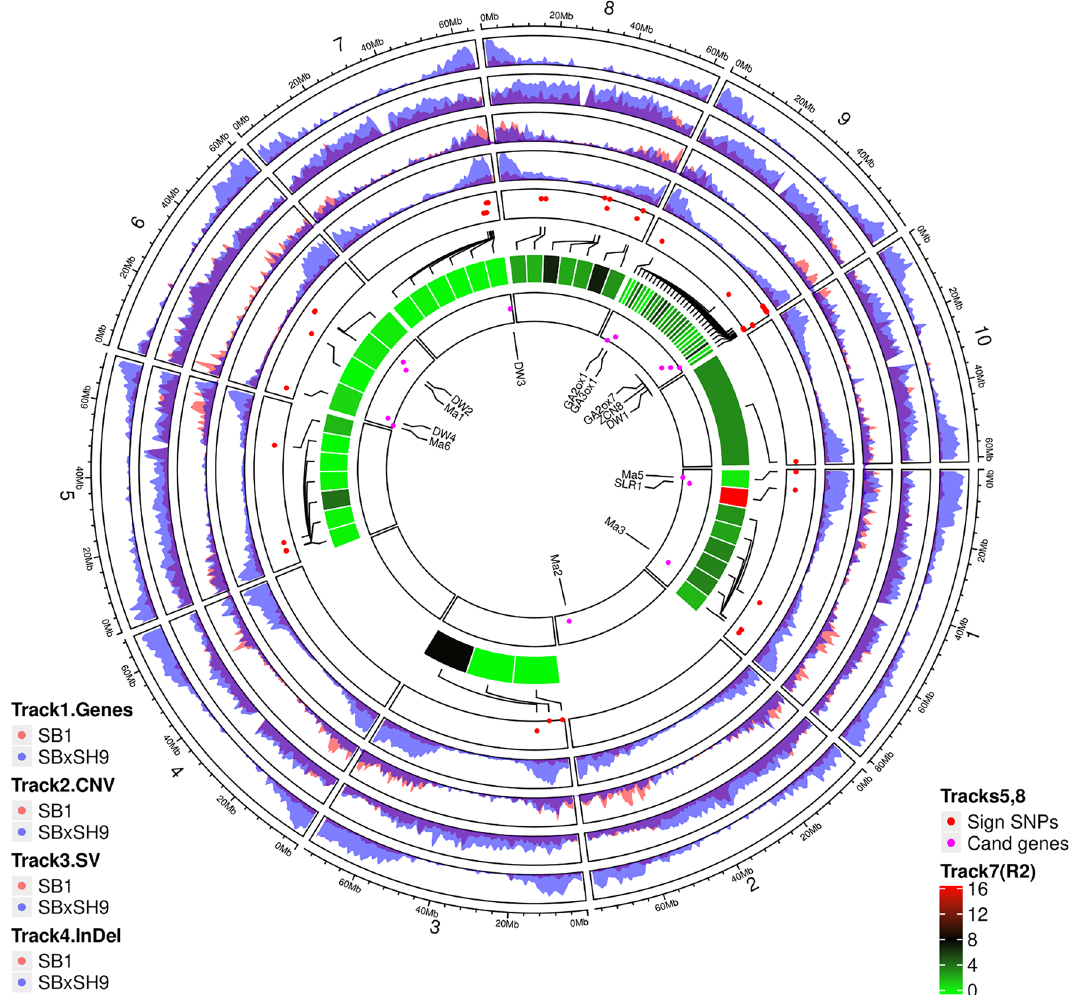
Figure 2. Chromosomal distribution of WGRS information in Sb and BC1 SbxSh lines, and GWAS data from the evaluated populations 74 . The x-axis corresponds to the genomic coordinate. Tracks 1–4: visualize the genomic density of regions (defined as the fraction of a genomic window that is covered by genomic regions). Tracks 5, 8: significant SNPs and candidate genes are displayed according to their genomic coordinates (x-axis), while y-values were set for the sole purpose improving the resolution (legibility) of the corresponding SNPs and candidate genes.